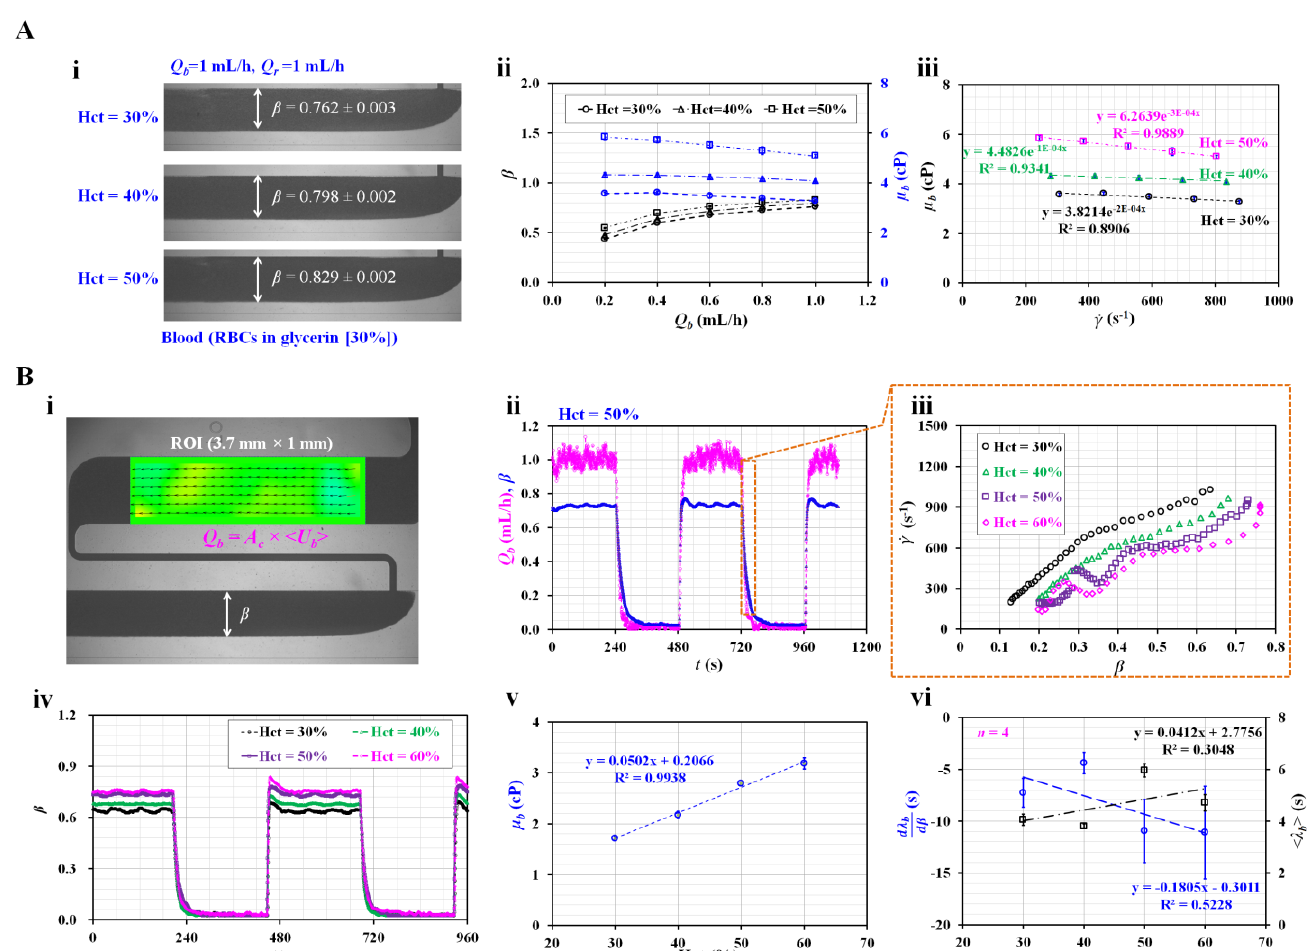
Figure 5. Contribution of Hct to haemorheological properties (i.e., viscosity and time constant) under steady flow rate and square-wave profile of blood flow. ( A ) Effect of Hct on blood viscosity under steady blood flow. ( i ) Variation in β with respect to Hct. ( ii ) Variation in β and µ b with respect to blood flow rate (i.e., Q b = 0.2, 0.4, 0.6, 0.8, and 1 mL/h) and Hct (i.e., Hct = 30%, 40%, and 50%). ( iii ) Variation in µ b with respect to shear rate and Hct. ( B ) Effect of Hct on the viscosity and time constant under square-wave profile of blood flow. ( i ) Quantification of flow rate and β . ( ii ) Temporal variations in Q b and β for blood (Hct = 50%). ( iii ) Variations in shear rate with respect to β and Hct = 30%, 40%, 50%, and 60%, under transient blood flow. ( iv ) Temporal variations in β with respect to Hct. ( v ) Variations in µ b with respect to Hct. ( vi ) Variations in 𝑑𝜆 𝑡 and < λ t > with respect to Hct. 𝑑𝛽 Second, instead of a steady flow rate, the flow rate was set to a square-wave profile (i.e., Q t 0 = 1 mL/h and T = 480 s). The blood viscosity was measured at a steady flow rate ( Q b = 1 mL/h). The time constant of the blood flow was obtained under transient blood flow by setting the blood flow rate from Q b = 1 mL/h to Q b = 0. Here, the Hct of blood was adjusted to 30%, 40%, 50%, and 60% by suspending normal RBCs in 1 × PBS. Figure 5B-i shows the q uantification of the blood flow rate ( Q b ) in the test fluid channel and the inter- face ( β ) in the coflowing channel. To estimate the variation in the shear rate under transi- ent blood flow, we obtained variations in Q b with respect to time. Here, a micro-PIV tech- nique was adopted to obtain the velocity fields of blood in the test fluid channel. After calculating the average velocity of blood (< U b >), the flow rate of blood ( Q b ) was obtained as Q b = A c × < U b >. Here, A c denotes the cross-sectional area. Figure 5B-ii shows the temporal variations in Q b and β for blood (Hct = 50%). Based on the temporal variations of Q b under transient blood flow, the shear rate of blood flow was estimated with respect to Q b . In addition, the variation in β was obtained at a specific time. Thus, we could create an XY